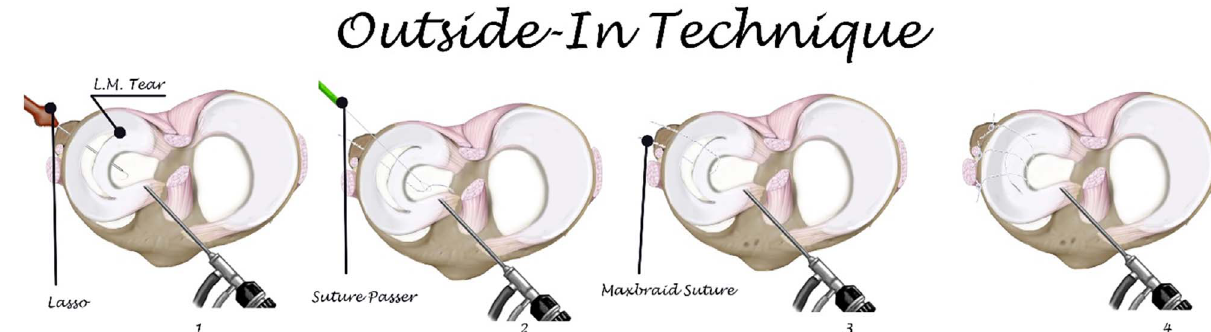
Figure 2. Steps of Outside-in